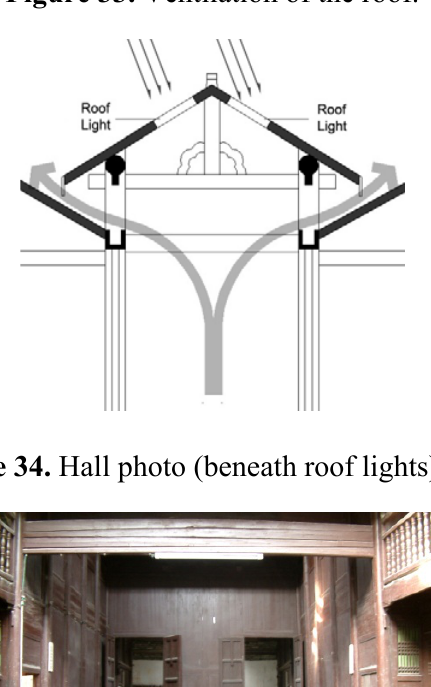
Figure 33. Ventilation of the roof.